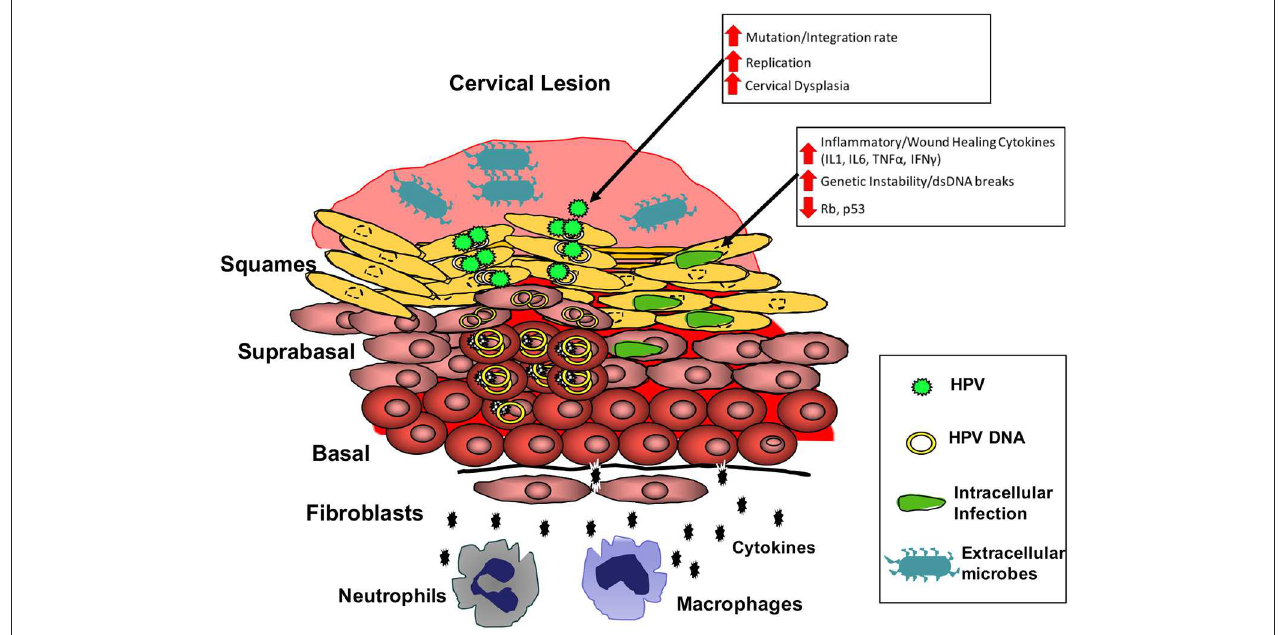
FIGURE 2 | Model for the cervical microbial and immune microenvironment driving cervical cancer. Microbial dysbiosis and infection at the cervical epithelium results in increased local expression of inflammatory and wound healing cytokines (IL1 and IL6). Chronic expression of these cytokines can result in increased genetic instability and reduced tumor-suppressor protein function in infected cells. These conditions increase HPV replication, while also increasing risk of mutation and integration of the HPV genome. Thus, the cervical microbiota can increase the risk for events necessary in the transformation of cells by